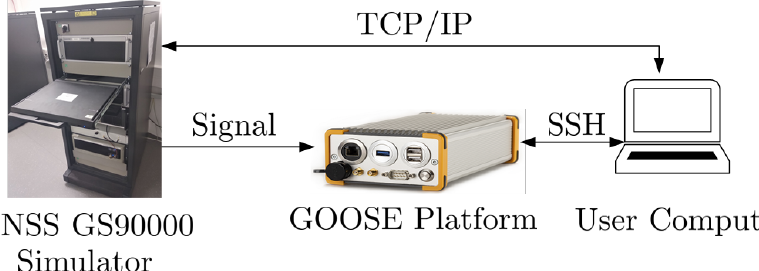
Figure 15. Setup for the simulation. ©IEEE. Adapted, with permission, from [7]. The generated scenarios are either static or have receiver dynamics. The static scenar- ios represent stationary use-cases such as GNSS reference stations, whereas the dynamic scenarios represent harsh vehicular conditions. Figure 16 shows the sky-plot of both sce- narios. There are 10 visible satellites during the simulation. However, SV G1 disappears behind the horizon after two minutes of simulation and SV G30 rises above the horizon near the end of the simulation. Therefore, the maximum number of visible satellites N Total is limited to